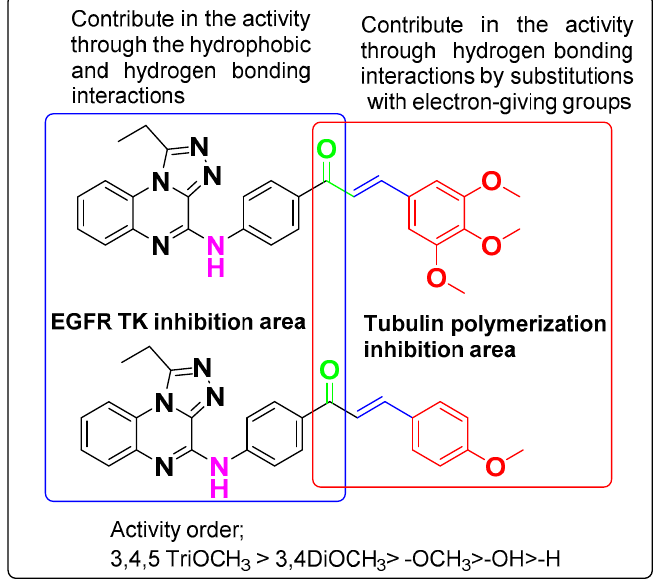
Figure 4. Structure activity relationship of chalcone derivatives 7e and 7g .